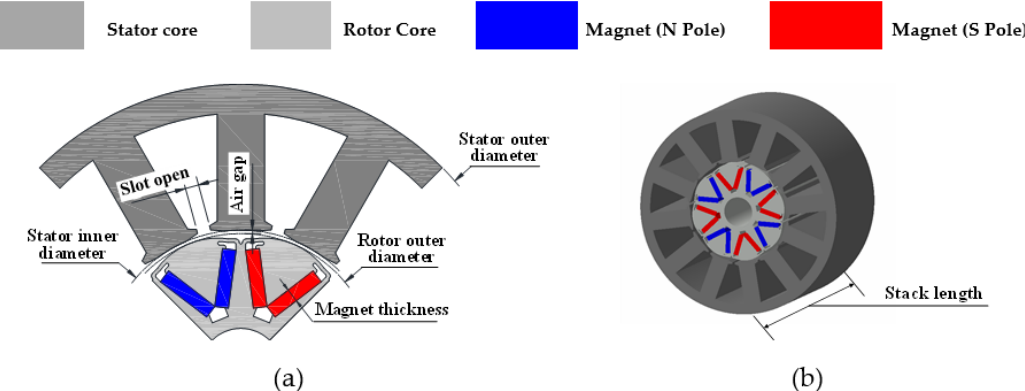
Figure 1. Shape of prototype model: ( a ) cross sectional view with 1/4 model; ( b ) stack length. Table 1. Design specification of prototype.